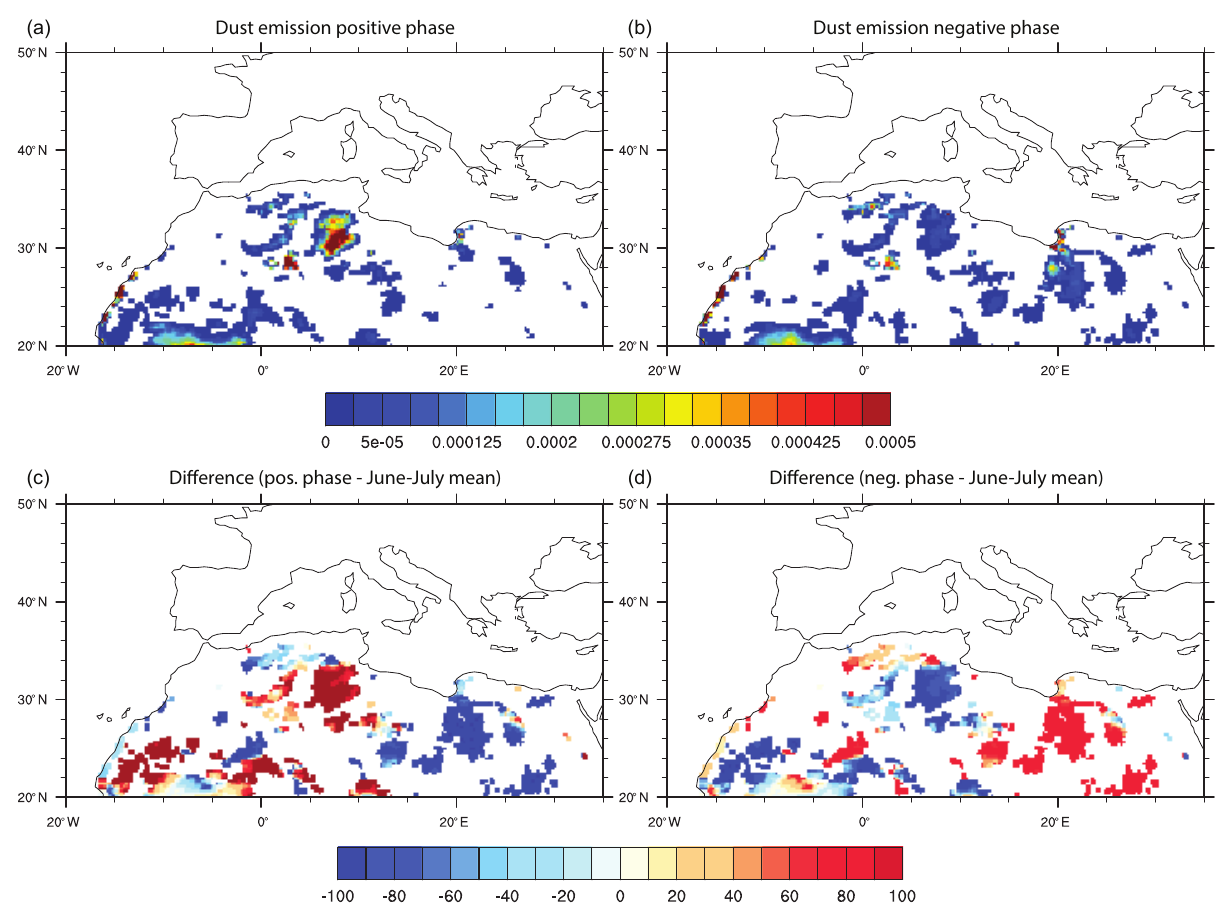
Figure 7. Composite of the COSMO-MUSCAT model dust emission flux (kgm − 2 d − 1 ) for positive (a) and negative (b) phases of the first EOF for June–July 2013. Panels (c) and (d) show the difference (%) of the average dust emission flux during (a) and (b) compared to the June–July 2013